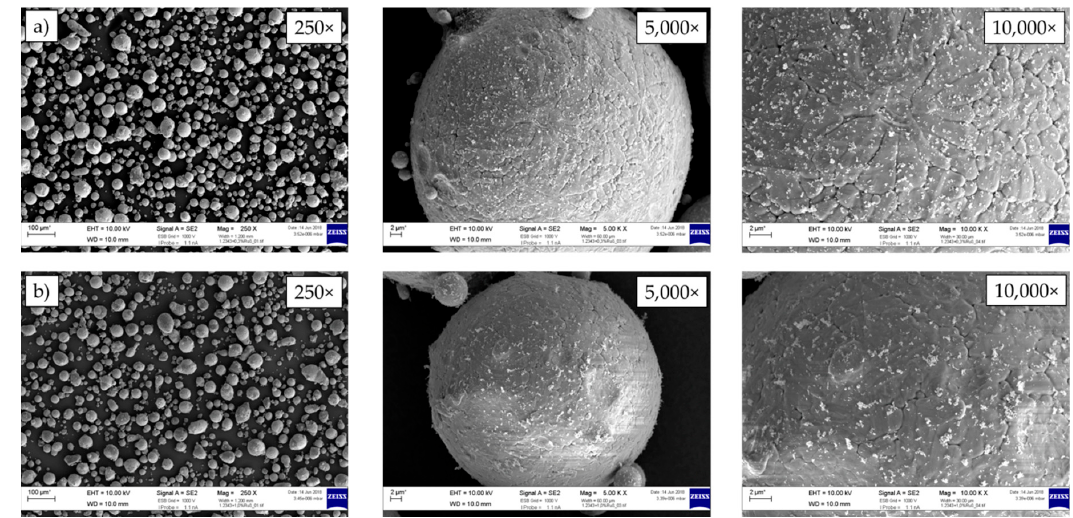
Figure 3. SEM images of modified tool steel powder mixtures containing ( a ) 0.3 wt. % and ( b ) 0.5 wt. % carbon black nanoparticles (from left to right, magnifications: 250×, 5000× and 10,000×, respectively).